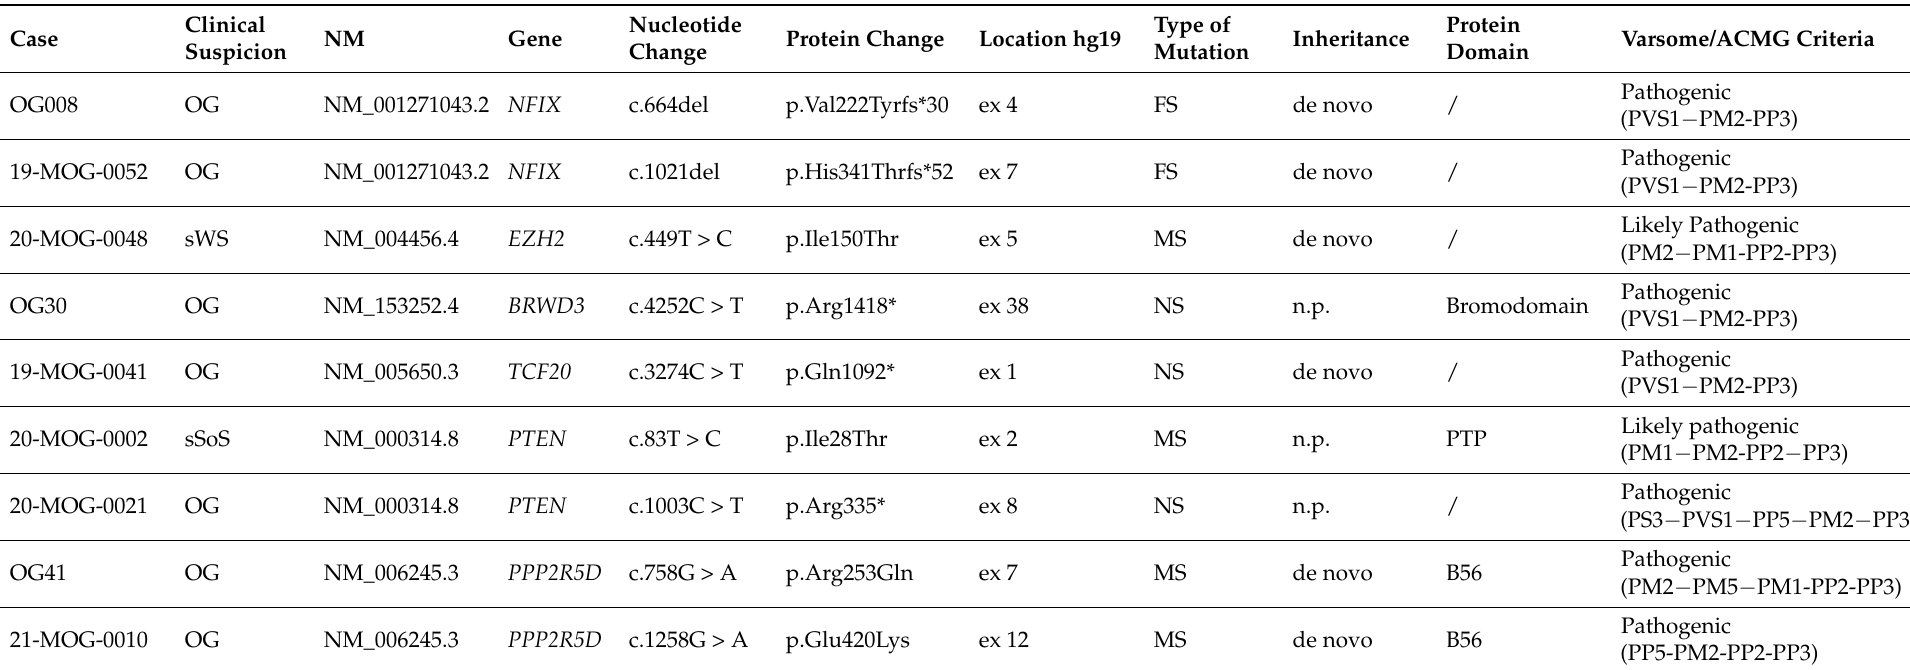
Table 4. Nine pathogenic or likely pathogenic variants identified in other genes in the present